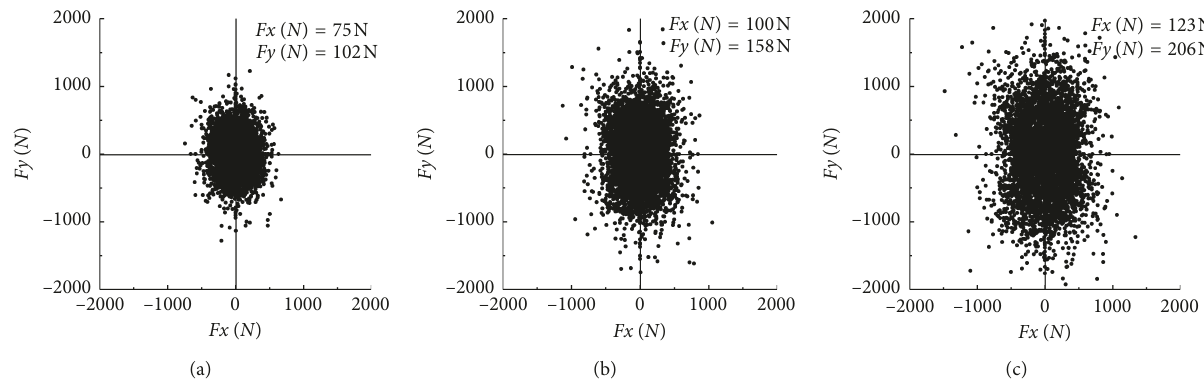
Figure 13: Distribution of the particle normal contact force and direction during the process of sample F2 loading: (a) ε 0 . (c) ε 1 (cid:30)